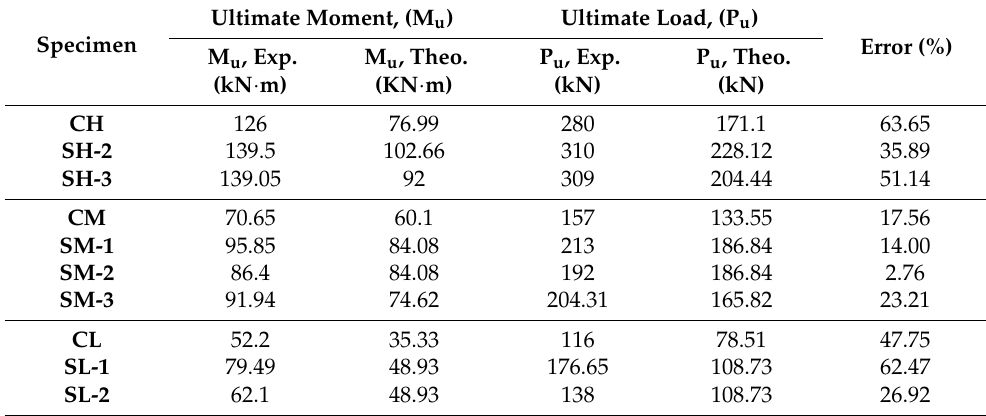
Table 6. Experimental and theoretical